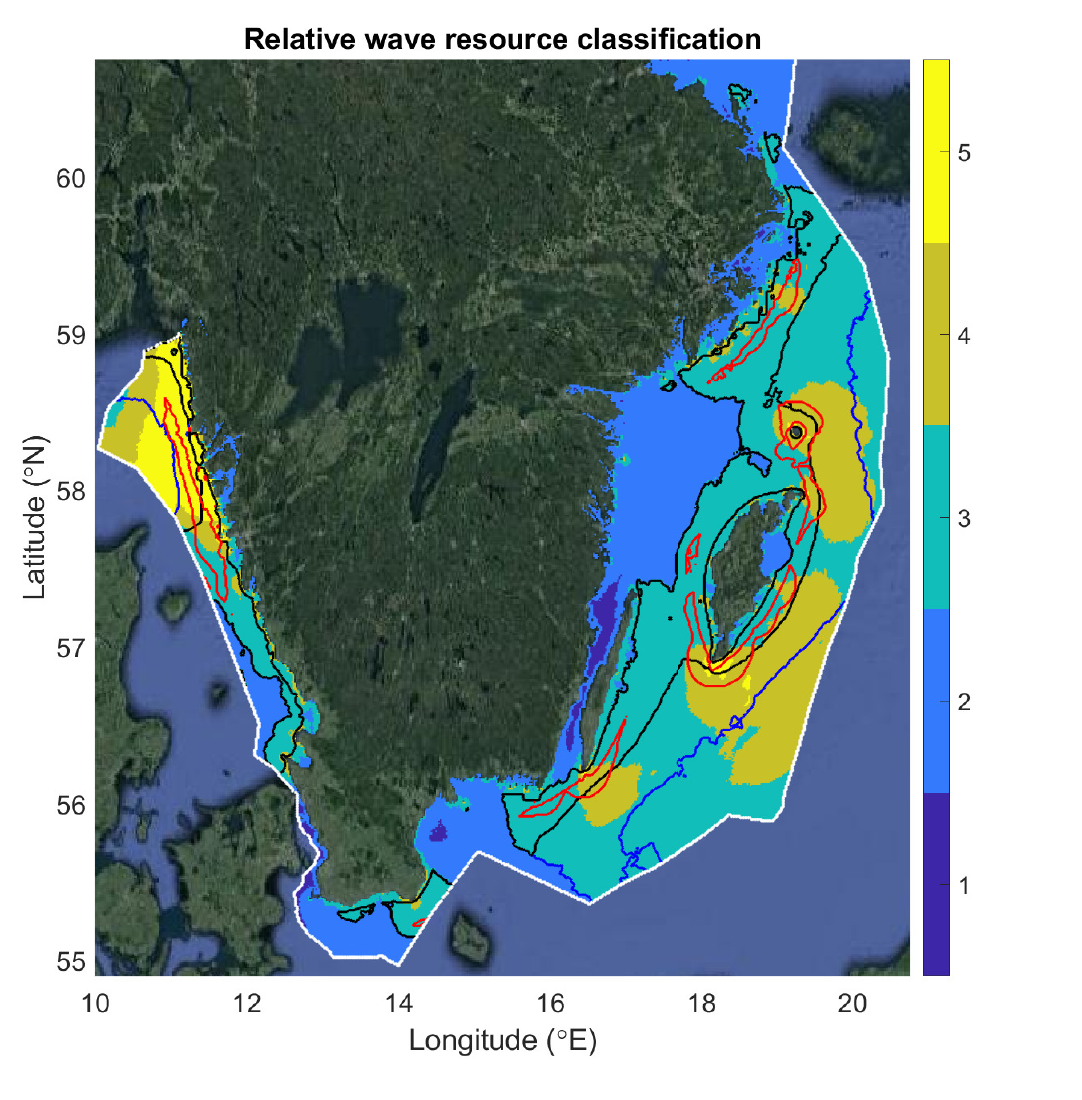
Figure 15. Relative classification of the wave power resource [6] in five categories comparing the power at sites relative to typical annual mean values for its given distance from the coast. Red lines correspond to the identified areas based on the criteria used in [6]; black lines encircle larger identified areas when including the choices for average relative suitability index for weather windows and waiting periods ignoring ice. This area extends further offshore to the blue line if those choices are excluded from the analysis. See Section 4.4 for further